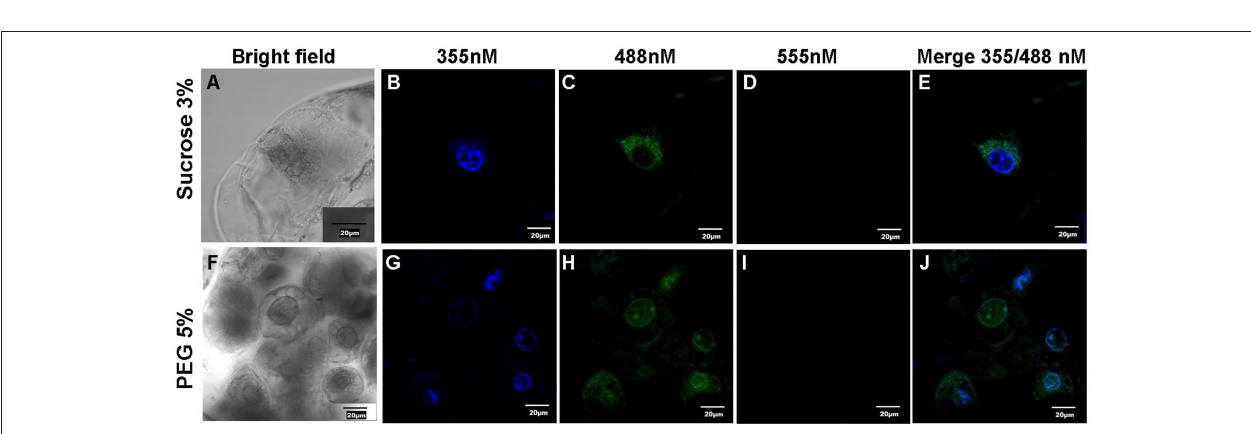
FIGURE 5 | Betalain synthesis in Stenocereus queretaroensis culture. (A) Time lapse of yellow cell (Sqy1) osmotic treatment. (A) , (D) , and (G) belong to the sucrose 3% media culture. (B) , (E) , and (H) are sucrose 8% condition. (C) , (F) , and (I) belong to PEG 6000 5% treatment. Time lapse was performed by 7 days. (B) Percentage of the red channel of the RGB measurement.